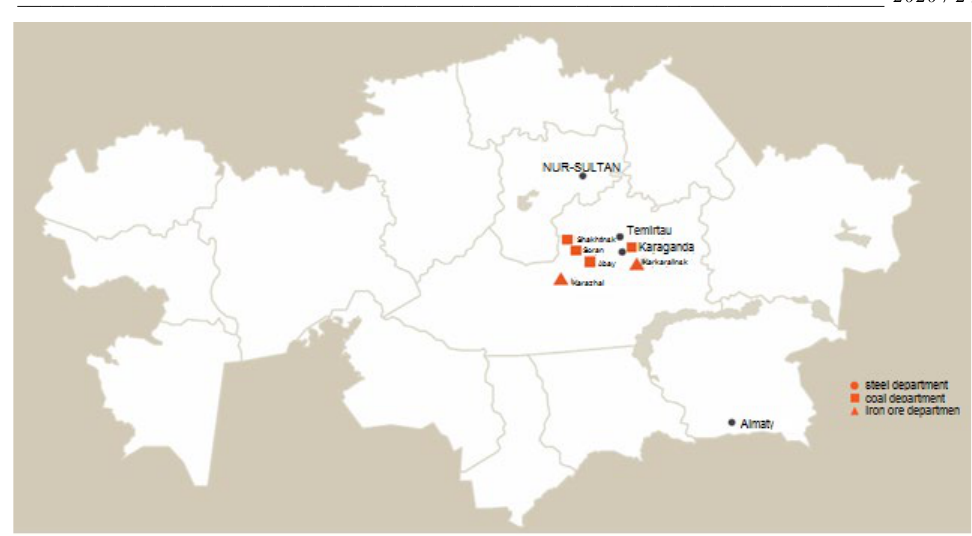
Fig. 2. Geographical representation of the metallurgical industrial cluster of the Republic of Kazakhstan (Karaganda